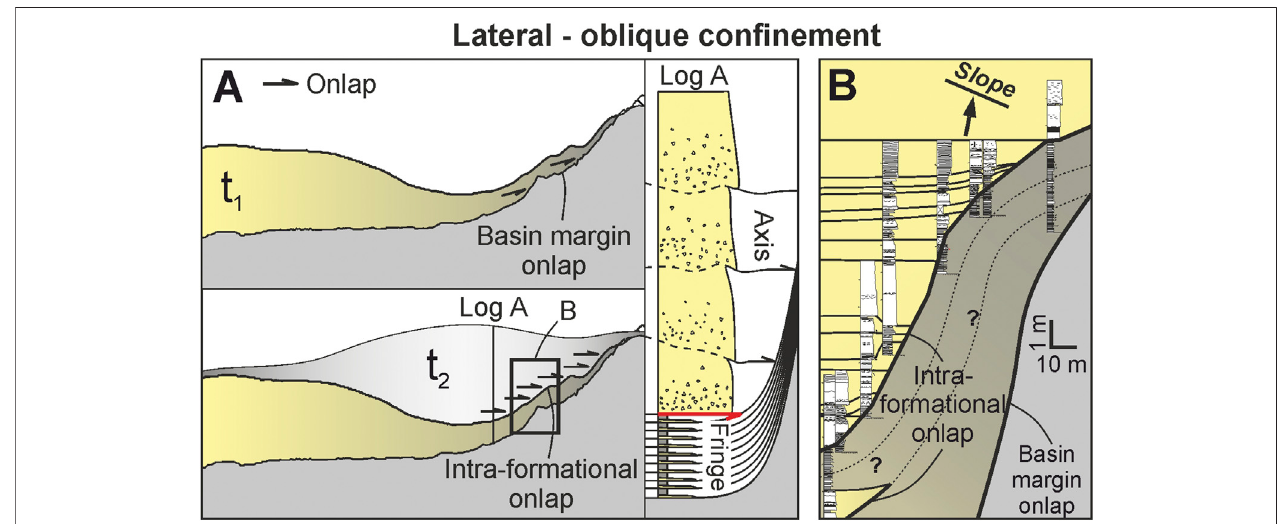
FIGURE14|(A) Schematicdiagramshowingthepredicteddepositionifanothercurrent(t 2 )wasabletodepositovertheobliquelycon fi nedt 1 andthesedimentary log representation of that geometry. Onlap occurs against the topography (basin margin onlap) and within the deposits (intra-formational onlap), through draping of the topography by the lower-concentration fringe. (B) A fi eld example of oblique con fi nement and onlap against the Annot Basin margin (modi fi ed from Soutter et al., 2019; ColduFa,44 ° 0 ′ 33.84 ″ N/6 ° 43 ′ 5.52 ″ E),showinganonlapgeometrythatmayhavebeenformedinthesamemannerasA.Questionmarksindicateuncertaintyin